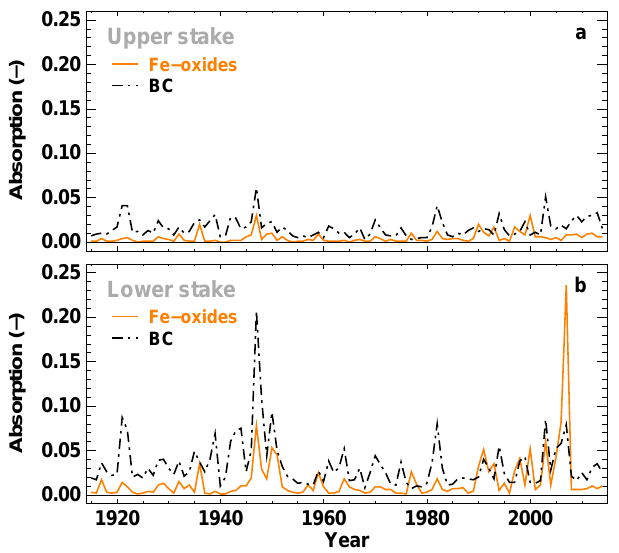
Figure 7. Cumulative mass balance over the period 1914–2014 at (a) the upper and (b) the lower measurement site. The solid blue line refers to the cumulative mass balance under real conditions (includ- ing Saharan dust and BC) and is consistent with the direct observa- tions on Claridenfirn. The dash-dotted lines correspond to simula- tions (1) without Saharan dust (with BC), (2) without BC (but with Saharan dust), and (3) with pure snow conditions. The grey shaded area indicates the thickness of the entire firn column in mw . e